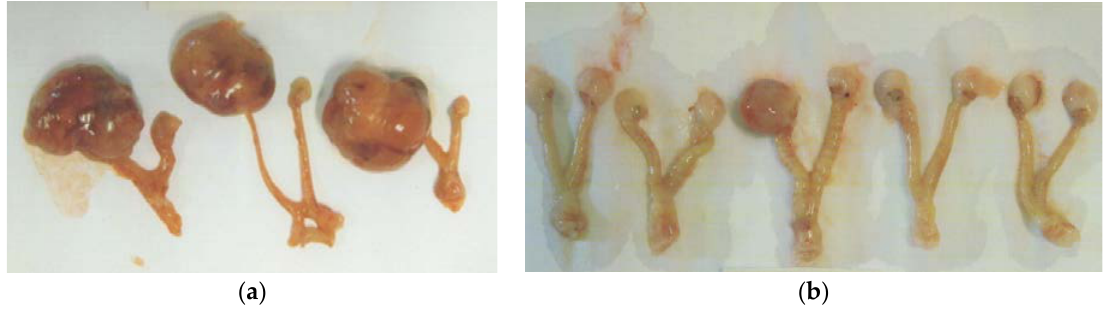
Figure 3. Gross photographs of representative ovarian tumors from groups. ( a ) Control, ( b ) EPQ group.